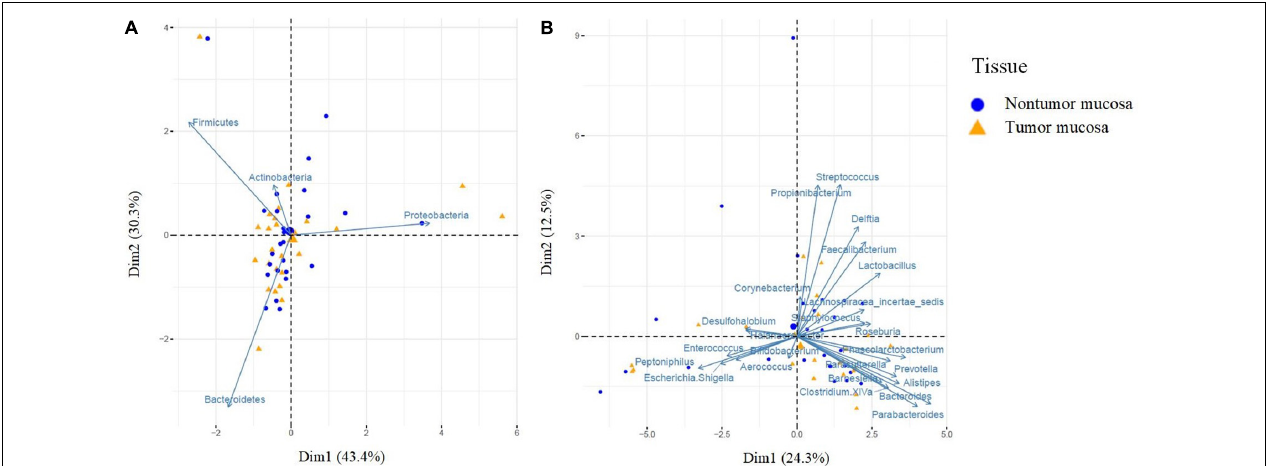
FIGURE 1 | Principal component analysis (PCA) of bacteria at the phylum (A) and genus (B) level according to the type of tissue. PCA was performed using the Euclidean distance as a metric element and the Kaiser criterion to select the number of components. PCA shows the microbial community composition in relation to non-tumor mucosa (blue cicles, n = 26) and tumor mucosa (yellow triangles, n = 26) from bladder cancer patients with paired samples. Principal component (PC1 and PC2) together, account for 73.7% (A) and 36.8% (B) of the variance in these data.